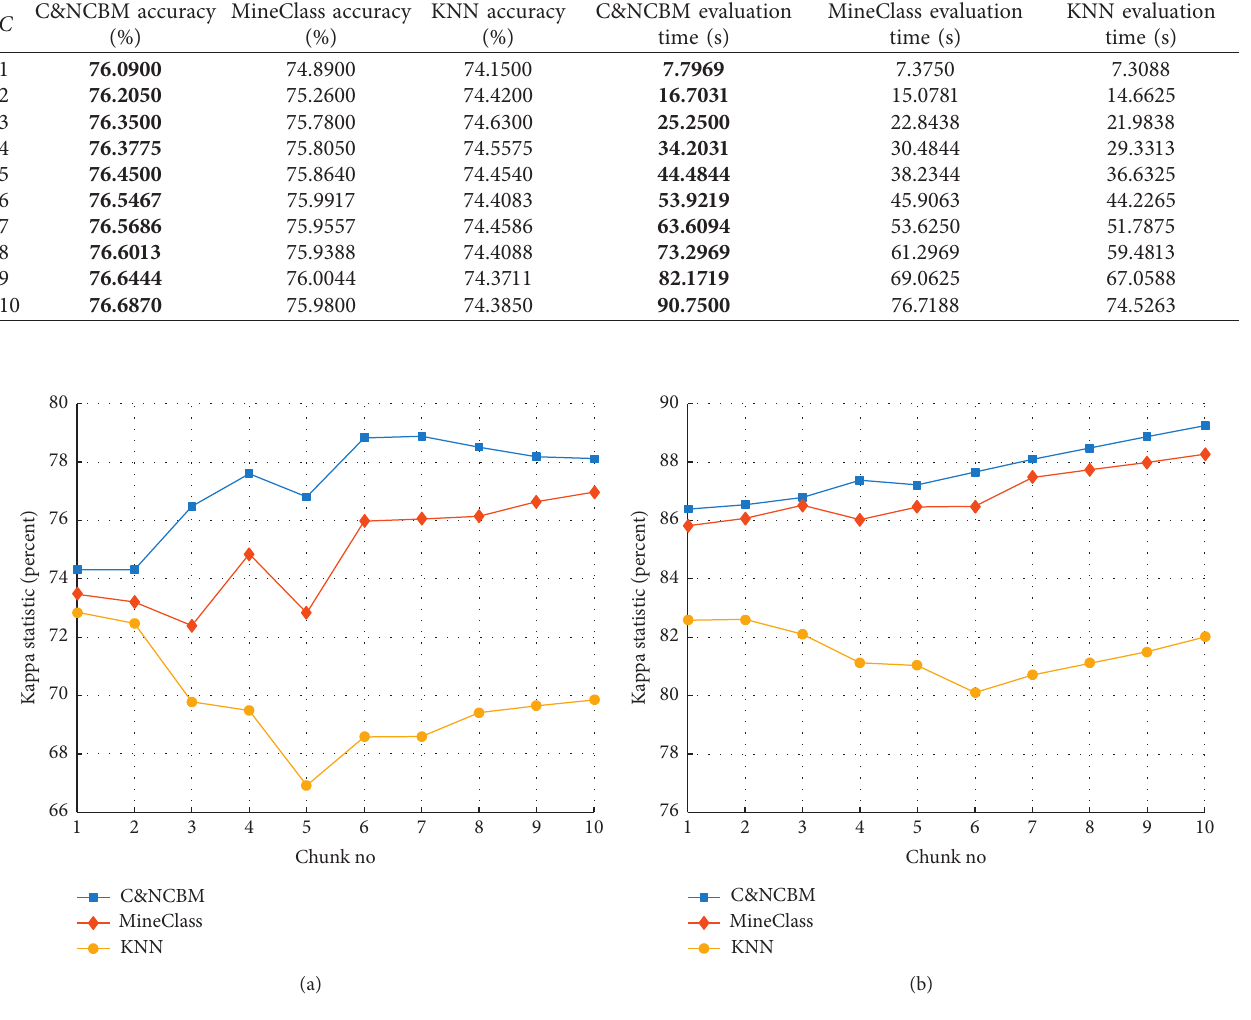
Figure 1: Comparison of Kappa Statistic on datasets. (a) The chunk size in the Covertype dataset is set to 58102, and (b) the chunk size in the ArtificialCDS dataset is set to 10000.